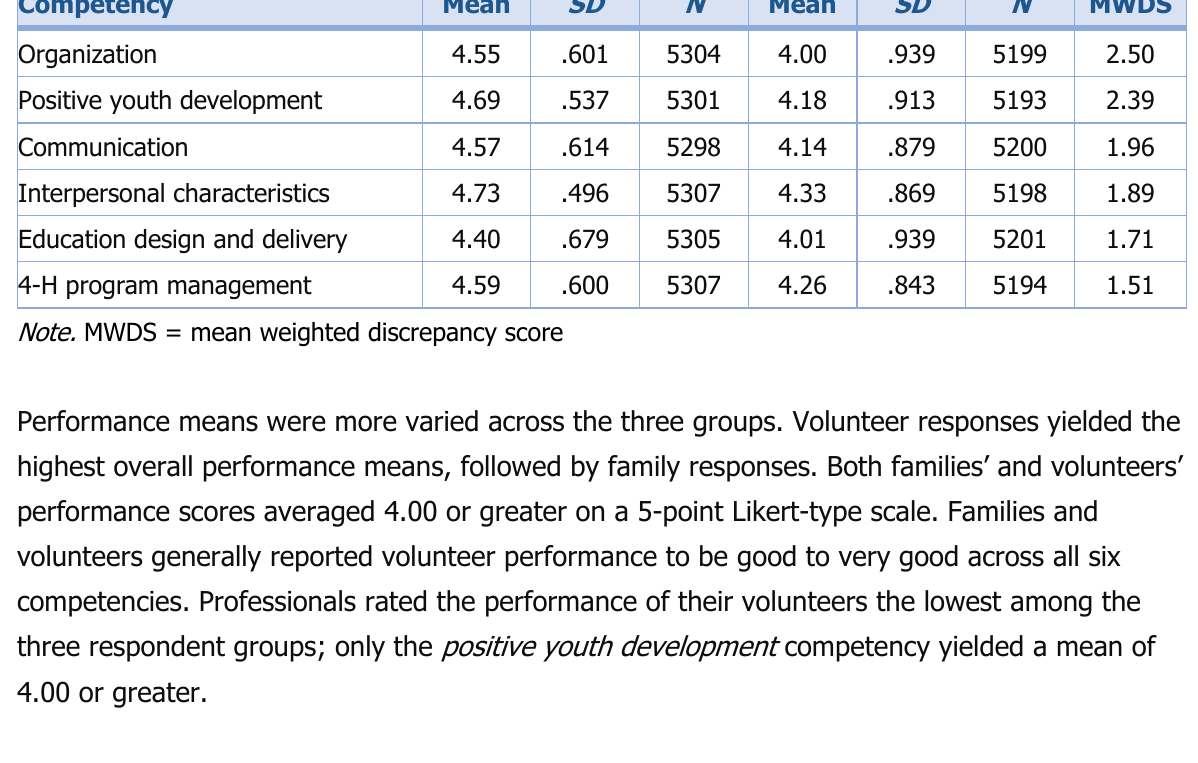
Table 5. 4- H Families’ Importance and Performance Scores